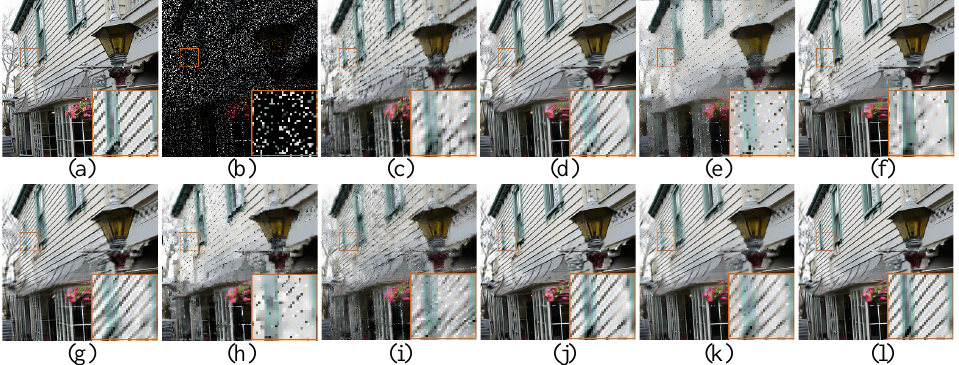
Figure 3. Visual comparison of Light by image inpainting with 80% missing pixels. ( a ) Original image; ( b ) Degraded image with 80% pixels missing; ( c ) BPFA [64] (PSNR = 19.26 dB, SSIM =